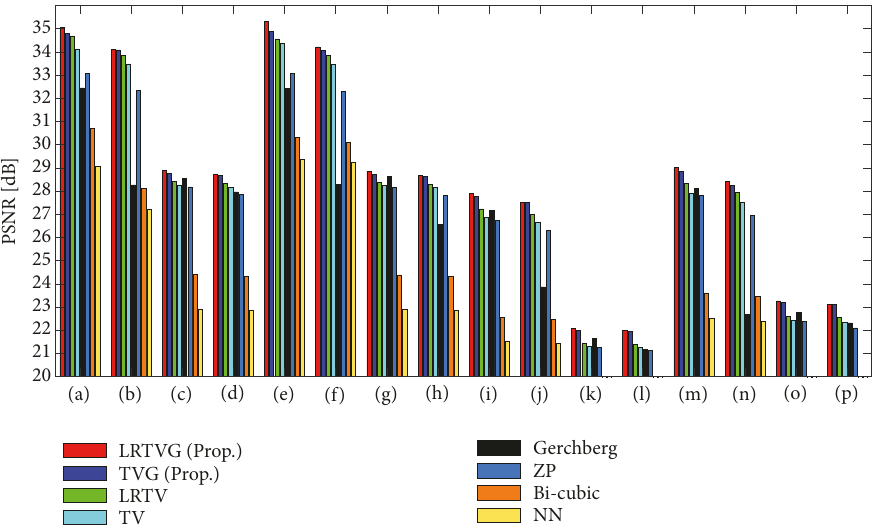
Figure 6: PSNR results of the variational simulations in Table